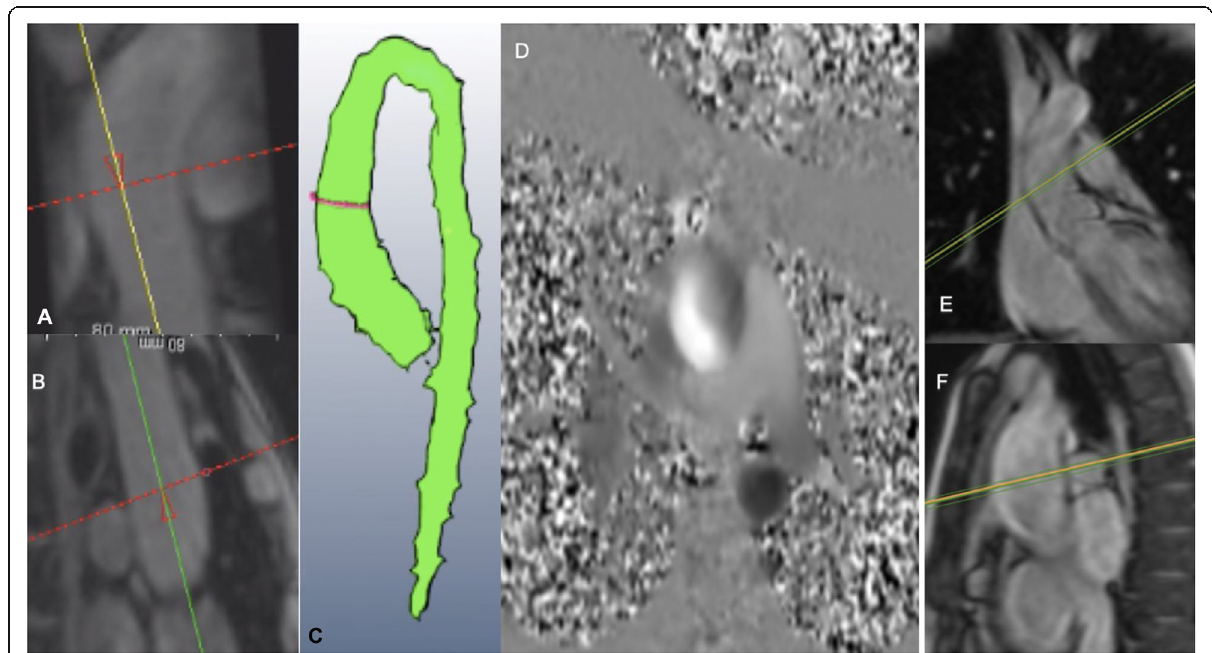
Fig. 1 Assessment of aortic 4D-flow, iso-surface images of the aorta (green) are produced. The post processing manual contour delineation was performed at the level of the pulmonary artery bifurcation (cross